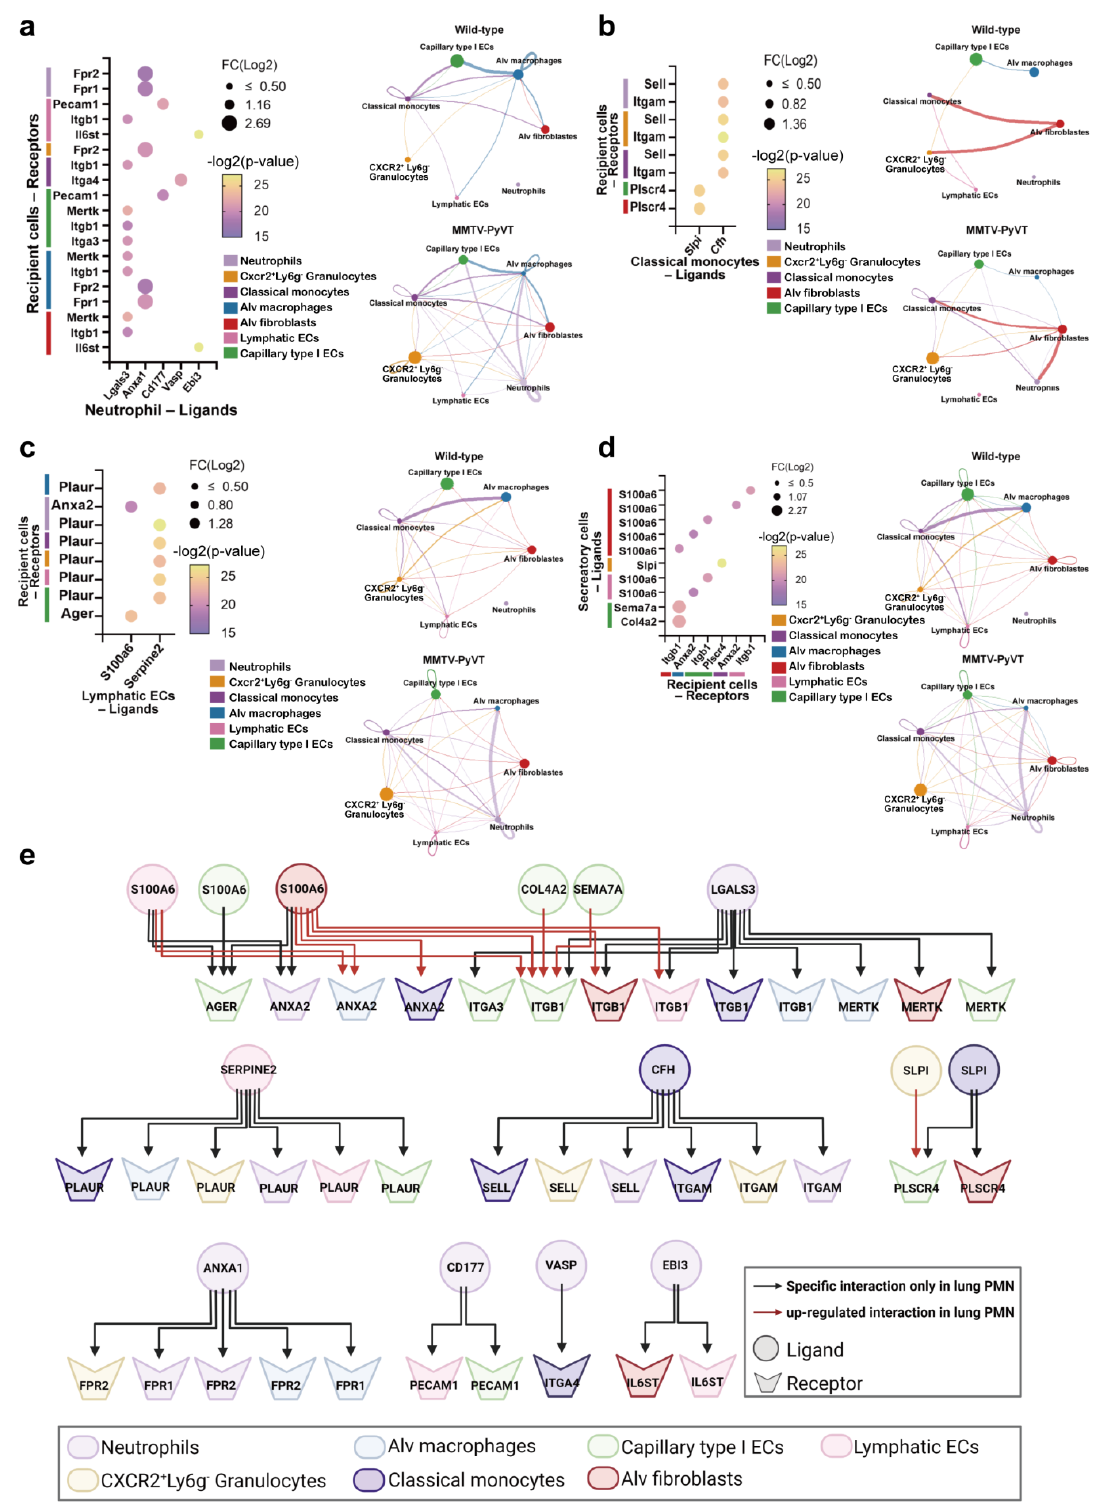
Figure 7. Interaction of cell types in the lungs of MMTV-PyVT mice. ( a ) The interaction of neutrophils with other cell types in the lungs of MMTV-PyVT mice. ( b ) Classical monocytes acted as secretary cells in the lungs of MMTV-PyVT mice. ( c ) Elevated S100A6-mediated interactions of lymphatic ECs in MMTV-PyVT mice. ( d ) S100A6 contributed to the interactions between alv fibroblast with other type cells. ( e ) Integrated critical network of cell–cell interactions in the lung PMN of MMTV-PyVT